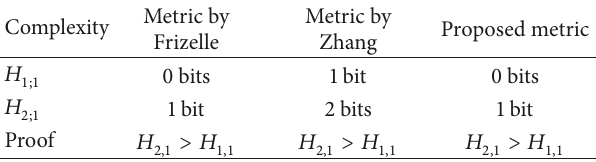
Table 2: Static complexity values and their